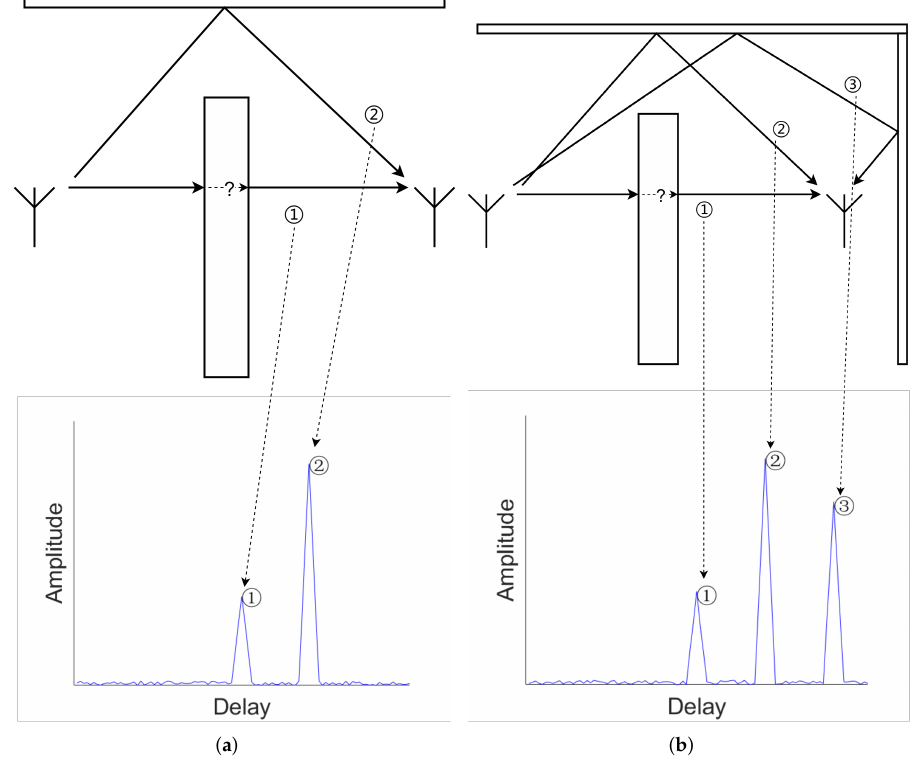
Figure 2. CIR of NLOS conditions. ( a ) Simple NLOS. ( b ) Complex